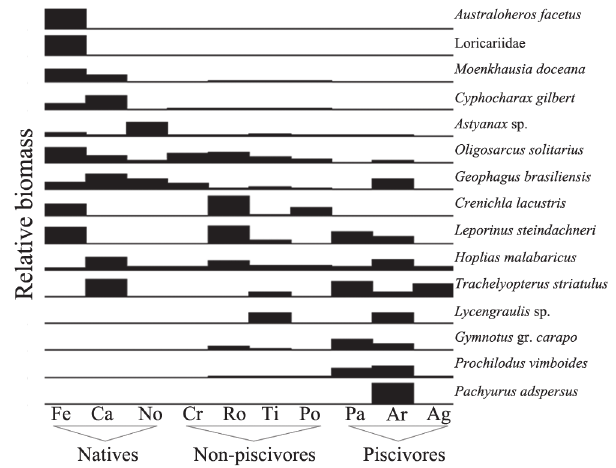
Fig. 4. Scatterplot of species body size (mean standard length) vs . a relative index of native affinity to lakes containing piscivorous invaders (the proportion of biomass of a given native species in lakes with piscivorous invaders). The estimated regression line is also presented (Y = 0.044*X - 0.279; R 2 = 0.443; p = 0.007). Species codes: ast = Astyanax sp.; aus = Australoheros facetus ; cyp = Cyphocharax gilbert ; cre = Crenicichla lacustris ; geo = Geophagus brasiliensis ; gym = Gymnotus gr. carapo ; hop = Hoplias malabaricus ; lep = Leporinus steindachneri ; lor = Loricariidae (unidentified species); lyc = Lycengraulis sp.; moe = Moenkhausia doceana ; oli = Oligosarcus solitarius ; pac = Pachyurus adspersus ; pro = Prochilodus vimboides ; tra = Trachelyopterus striatulus .